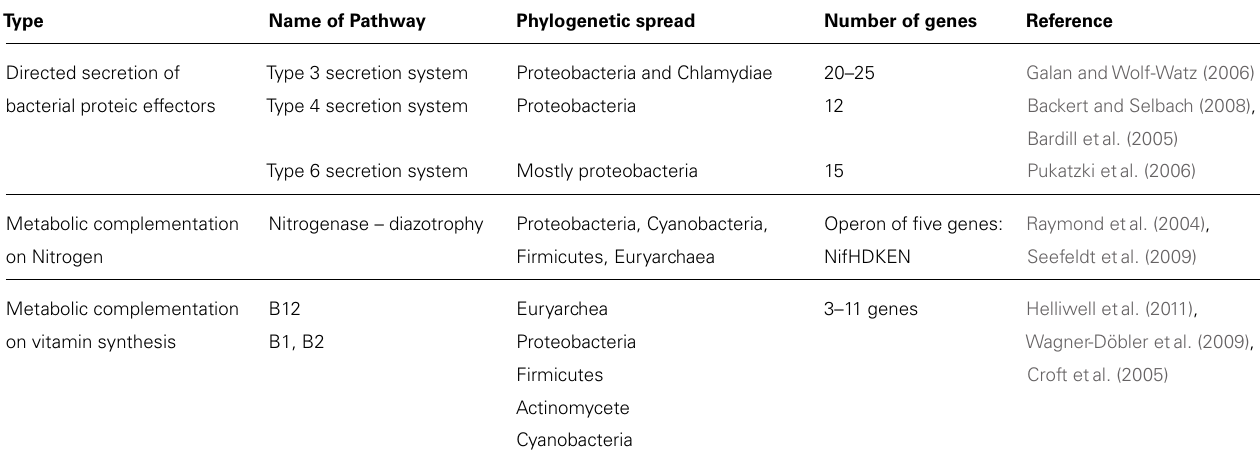
Table 1 |The Molecular toolkit of bacteria – eukaryote interactions: examples of bacterial target genes for screening genomes and metagenomes.